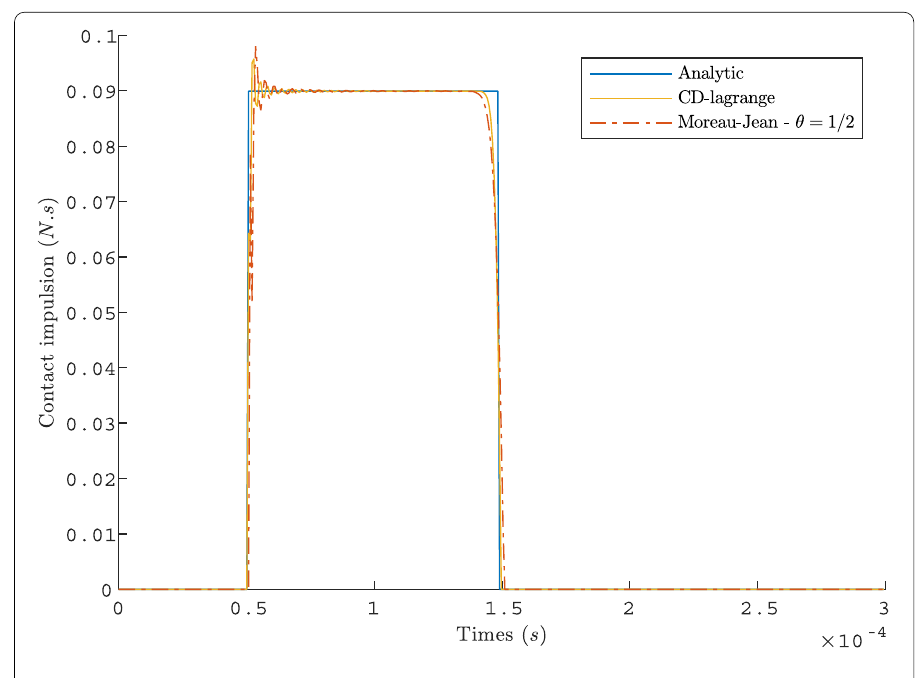
Fig. 22 Impacting bar—impulsion at contact